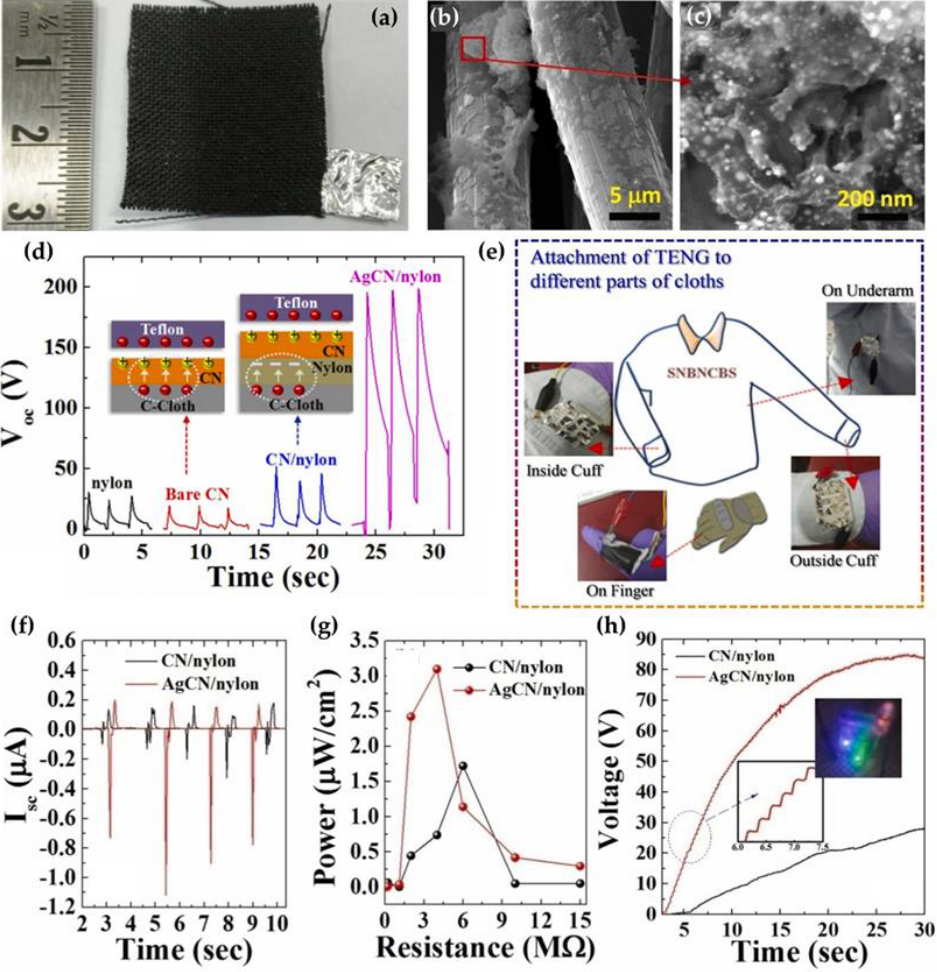
Figure 5. Photograph of an Ag/g-C 3 N 4 /nylon coated C-cloth with Al electrode ( a ); SEM images of Ag/g-C 3 N 4 decorated on nylon coated C-cloth under lower and higher magnification ( b , c ); open